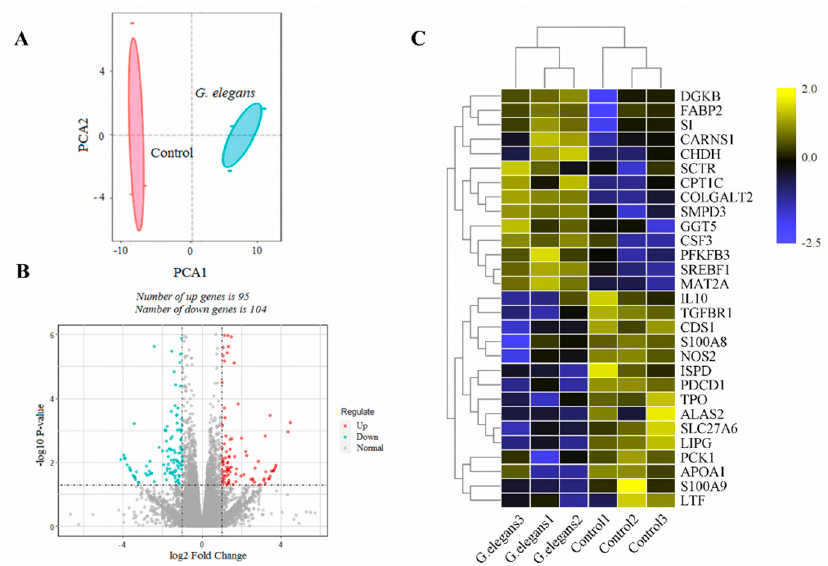
Figure 1. Differences in the expression levels of genes and metabolism-related alterations at the transcriptional level in piglet liver after G. elegans feeding. ( A ) PCA score plot of the genes identified from the control and G. elegans -treated group comparison. ( B ) Volcano plot of differentially expressed genes. Log2 fold changes in gene expression based on RNA-seq in the control and G. elegans -treated groups, and the corresponding significance values are displayed as log10 ( p value). The transverse and vertical dotted lines indicate the cutoff value for differential expression ( p < 0.05 and |log2 fold changes| > 1). In total, 95 and 104 genes with increased (red) or decreased (blue) expression levels induced by G. elegans exposure were identified. ( C ) Hierarchical clustering based on the DEGs related to metabolism.